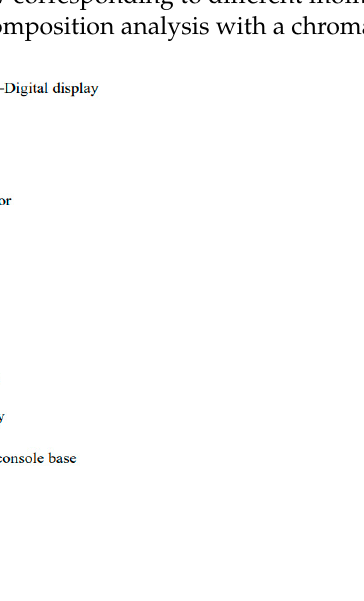
Figure 2. Diagram of a controlled temperature experimental apparatus for the slurry viscosity meas- urement.